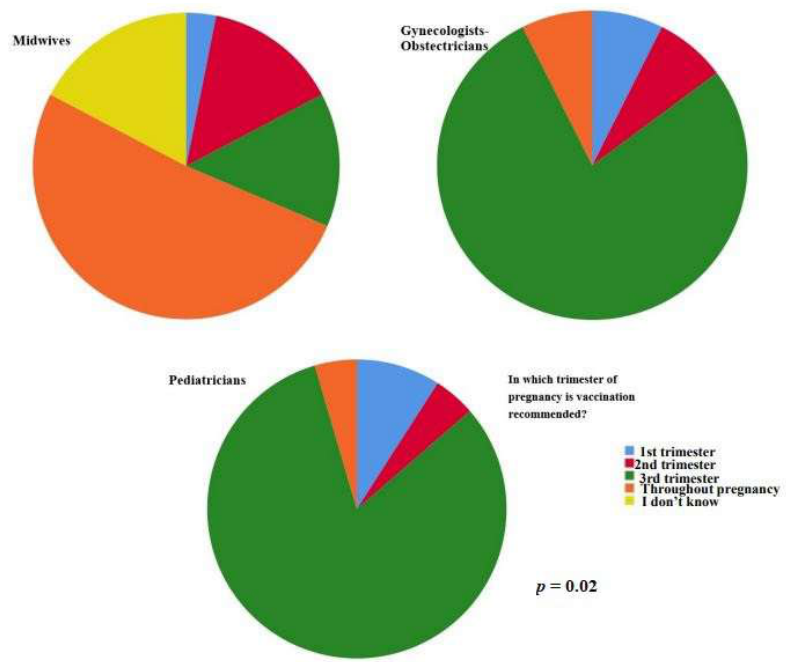
Figure 2. Midwife participants answered that vaccination is recommended throughout the entire pregnancy ( p =